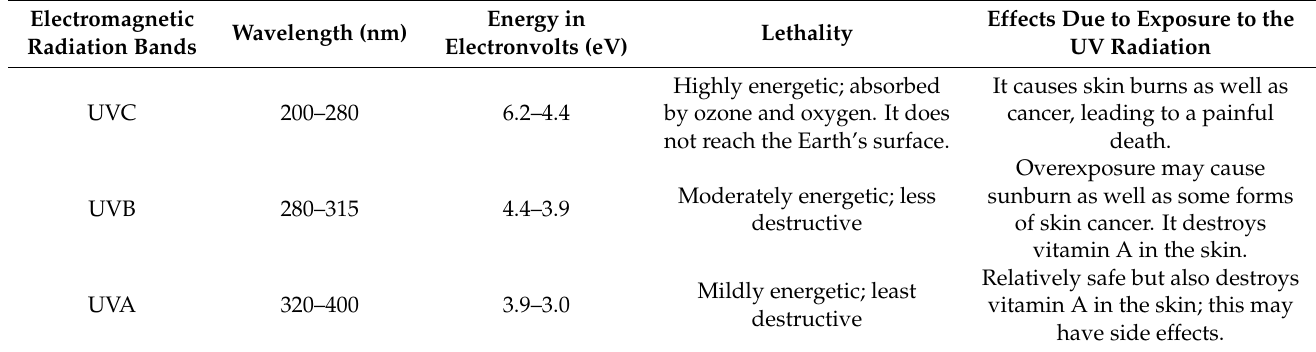
Table 1. A summarised list of the three types of UV radiation and their effects on humans. We also converted the wavelength (nm) to electronvolts (eV) for easier visualisation of energies involved. The higher the electronvolts number, the greater the energy delivered to the human